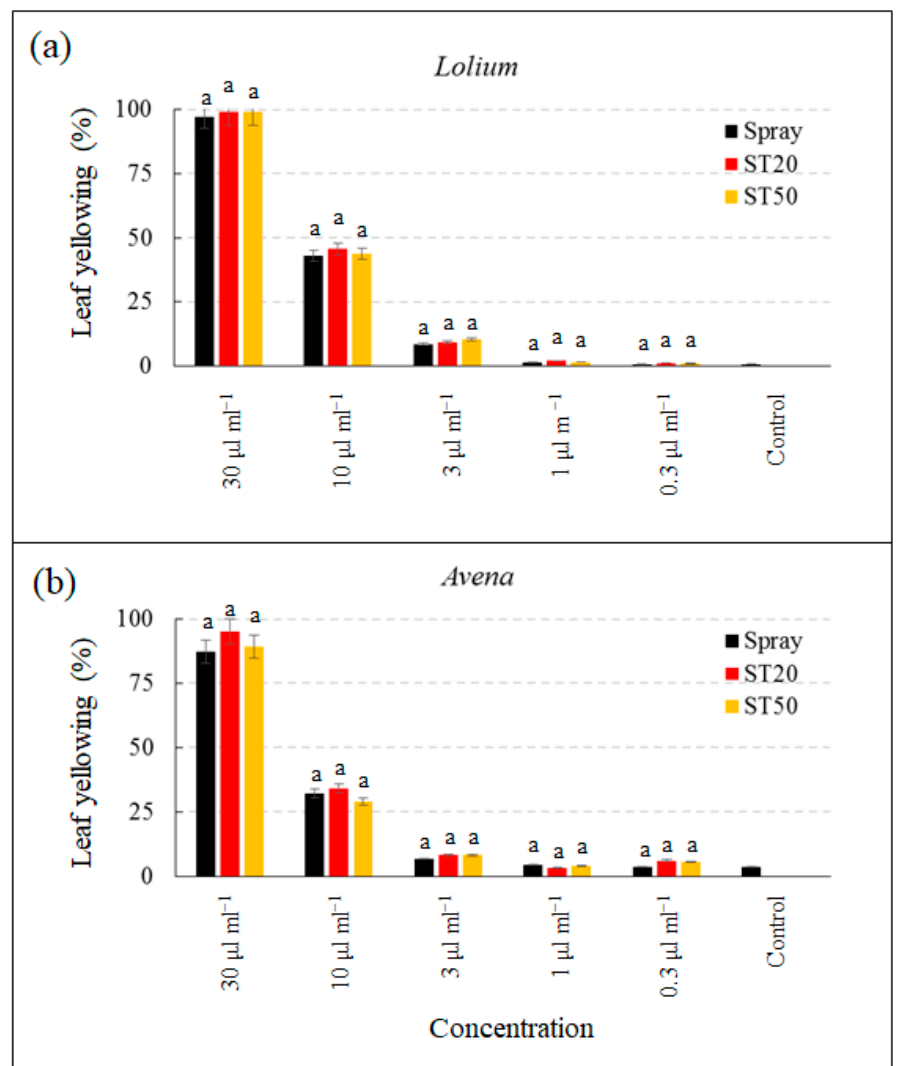
Figure 8. Percentage of yellowed leaf area of Lolium temulentum ( a ) and Avena fatua ( b ) treated with glyphosate at five concentrations with spray system, ST20, and ST50. Data are means ± standard deviation; different letters indicate statistically significant differences within concentration (Duncan’s test).